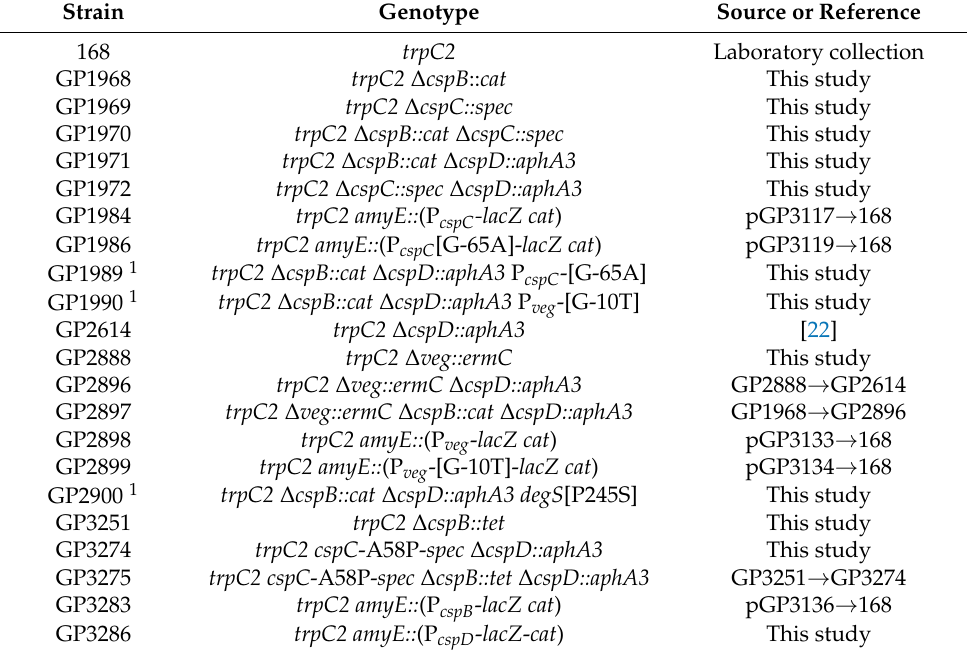
Table 1. B. subtilis strains used in this